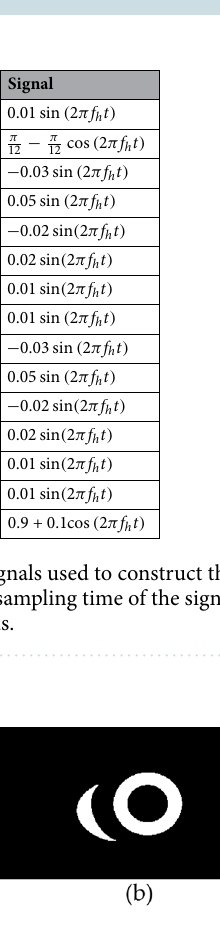
Figure 9. Slices from mid-ventricular section of the numerical phantom for ( a ) undeformed ( b ) deformed